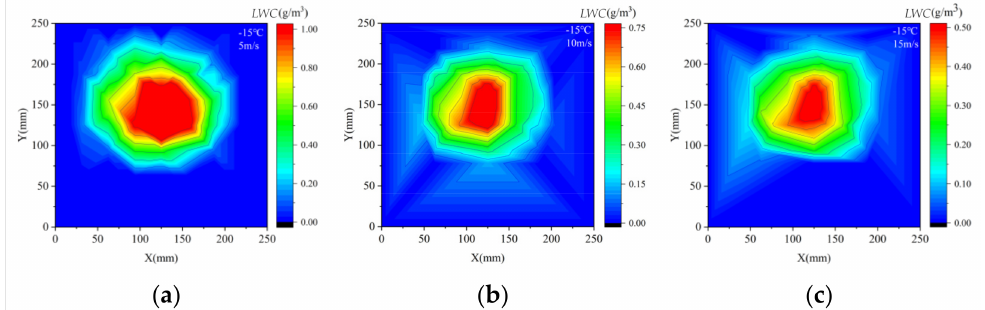
Figure 4. The calibration results of LWC . ( a ) 5 m/s, ( b ) 10 m/s, ( c ) 15 m/s.